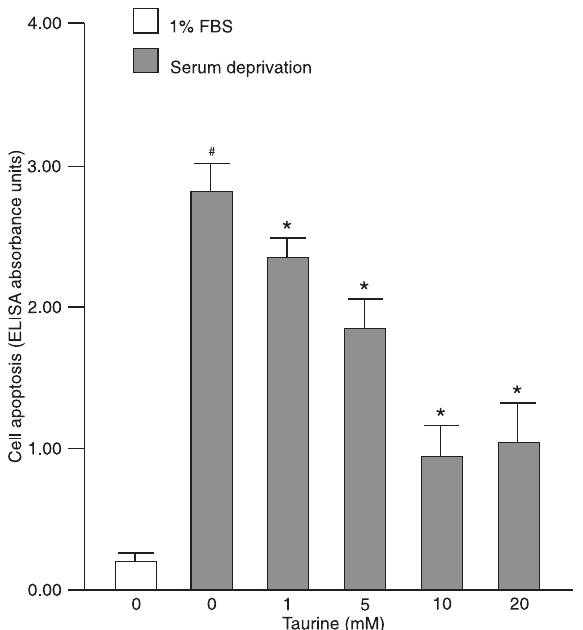
Figure 1. Effect of taurine on serum deprivation-induced apopto- sis of MC3T3-E1 cells. Cells were treated with 1 to 20 mM taurine in serum-free α-MEM for 48 h. Apoptosis was assessed using a Cell Death Detection kit, and reported as ELISA absorbance units. The bars indicate the mean ± SD (N = 5). # P < 0.05 vs 1% FBS-treated control; *P < 0.05 vs vehicle-treated serum-deprived group (one-way ANOVA).